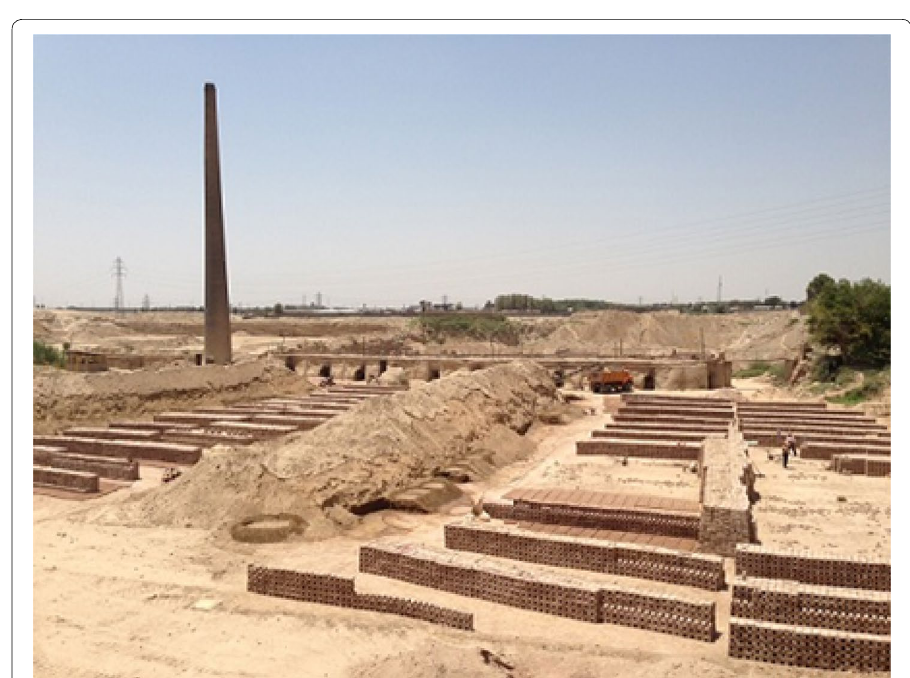
Fig. 22 Clay pit located north of HQHS-HSHT